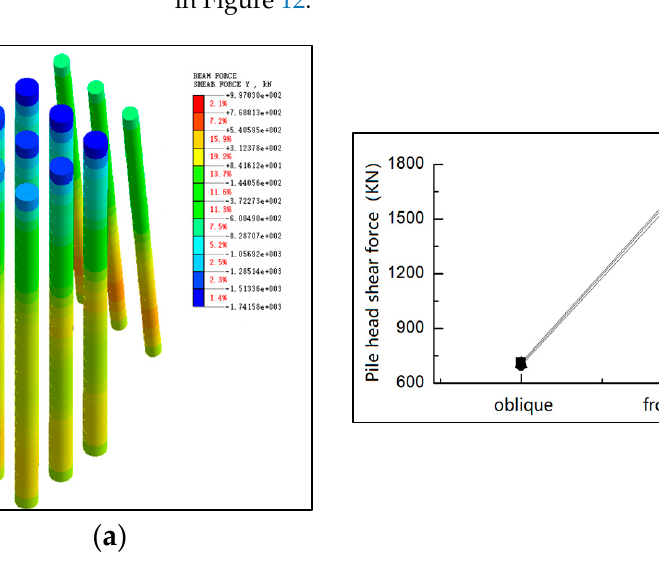
Figure 12. Diagram of maximum shear force on top of each pile.